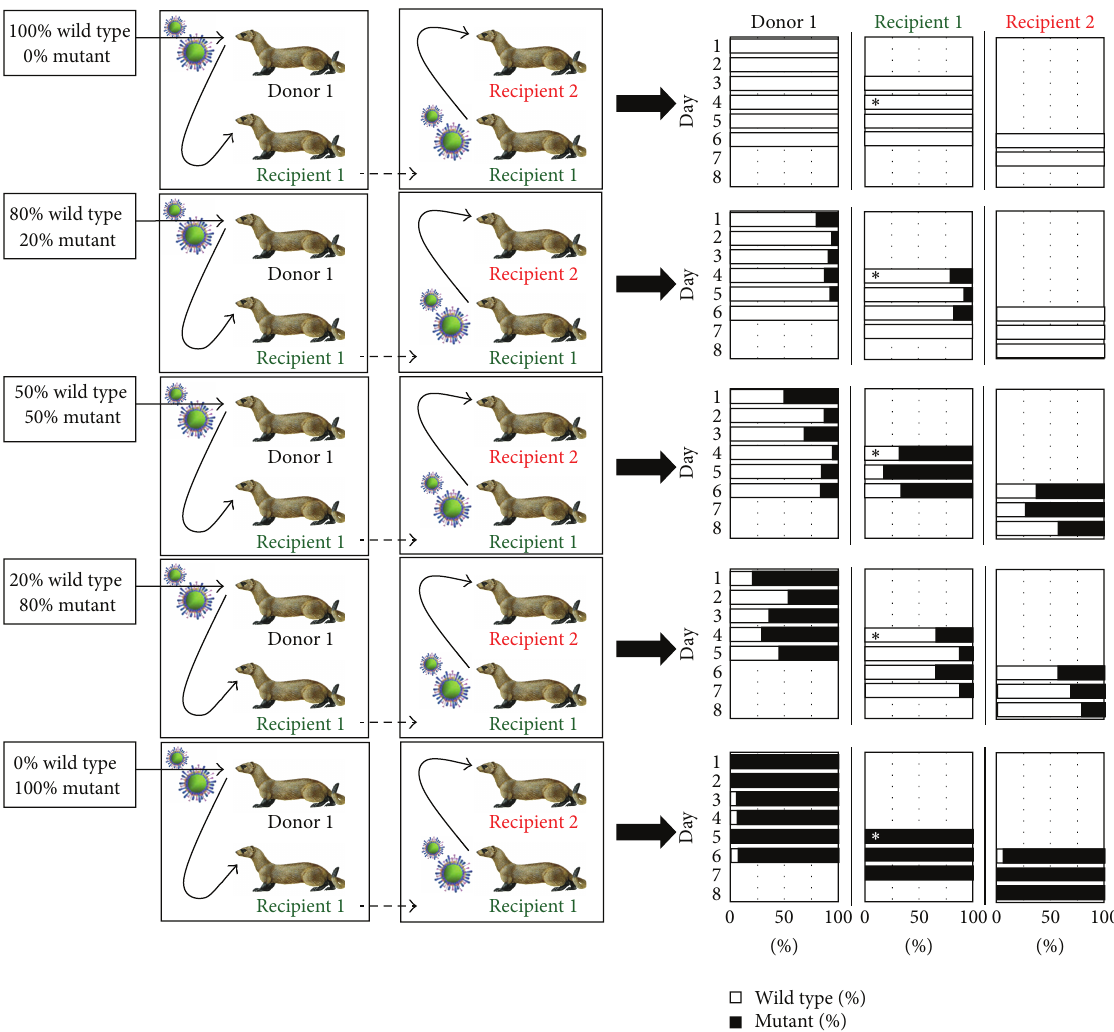
Figure 4: Overview of the competitive mixtures ferret model developed in our laboratory for assessing the relative fitness of a mutant virus compared to the wild